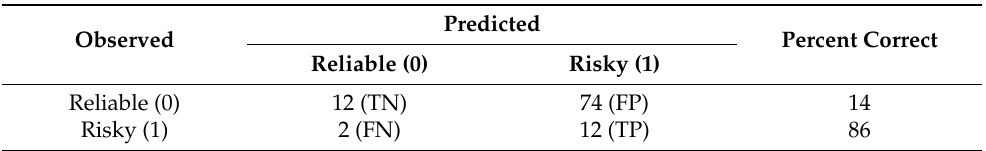
Table 9. Confusion matrix: prediction frequencies of risky and reliable borrowers based on the